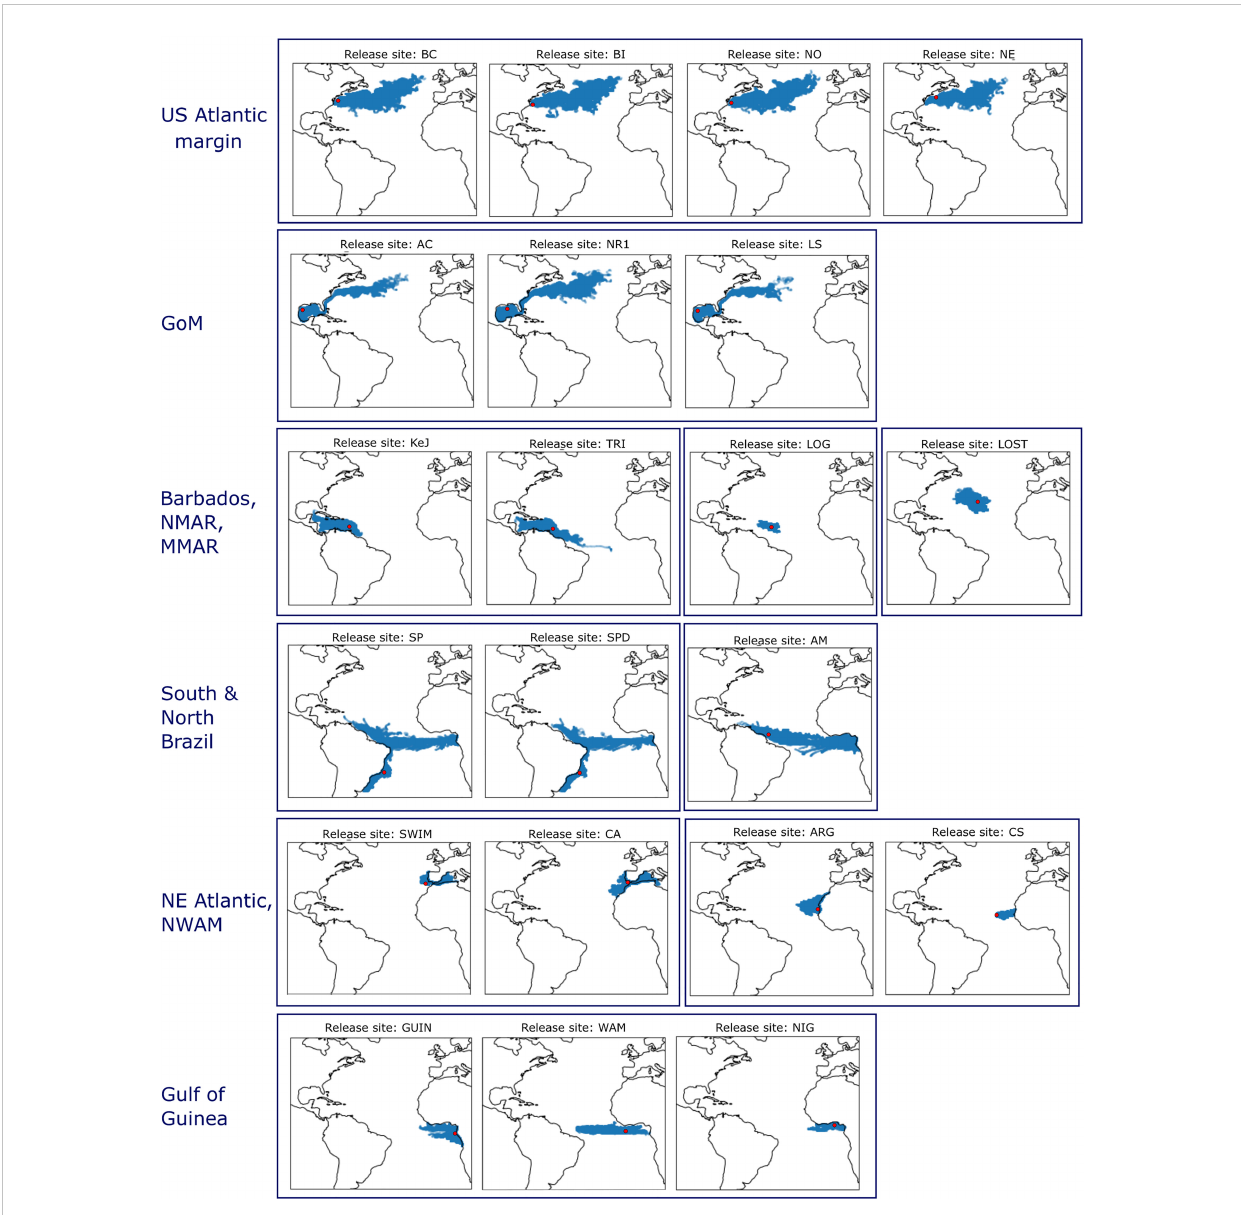
FIGURE 6 Representative patterns of simulated larval distribution after one year following a larval release at one of the 21 seep localities and/or putative stepping stones on the mid-Atlantic Ridge. Release date was January 2017 (see Portanier et al., 2023 and Jollivet et al., 2023 for all 25 release dates simulated). See Figure 1 for spawning areas and settlement regions abbreviation de fi